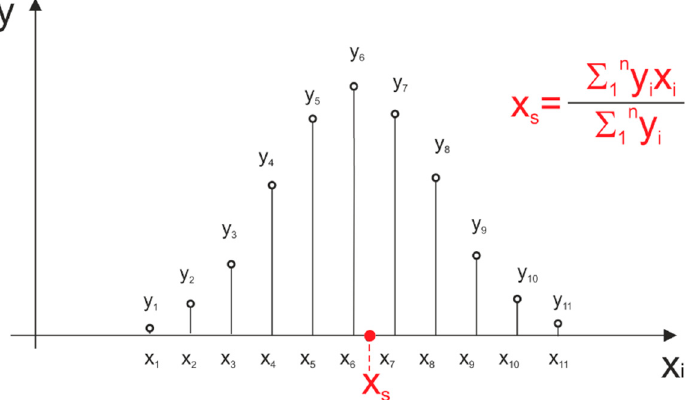
Figure 3. Weighted average as a method of finding the center x s coordinate of digitally recorded pulse.